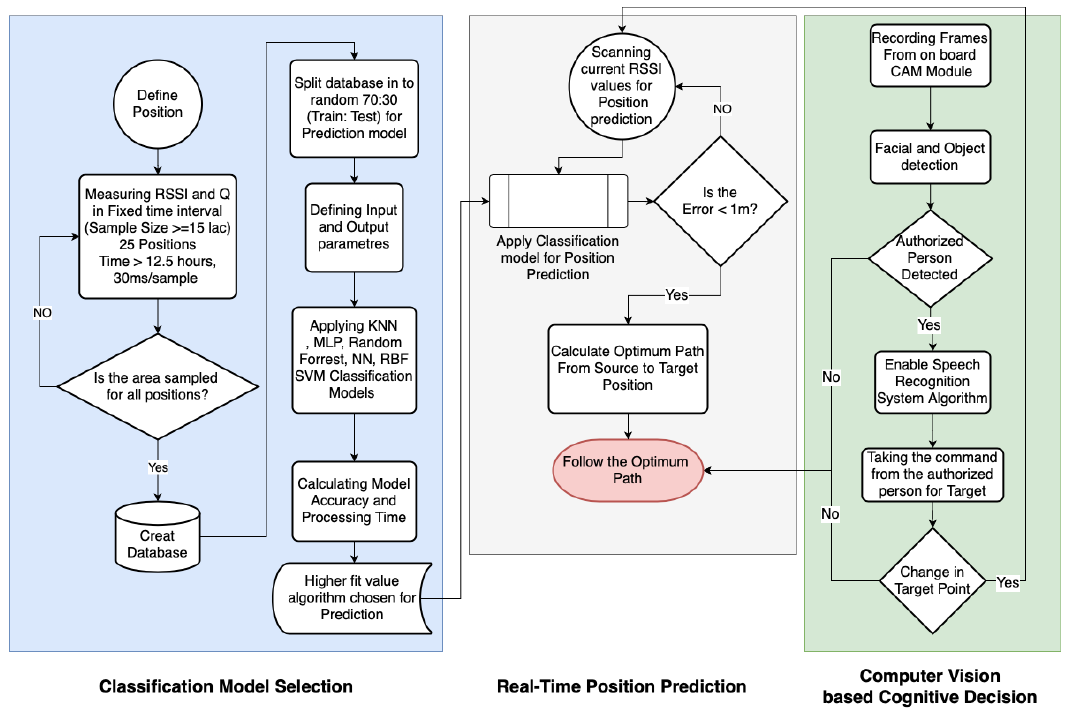
Figure 3. System flow graph.